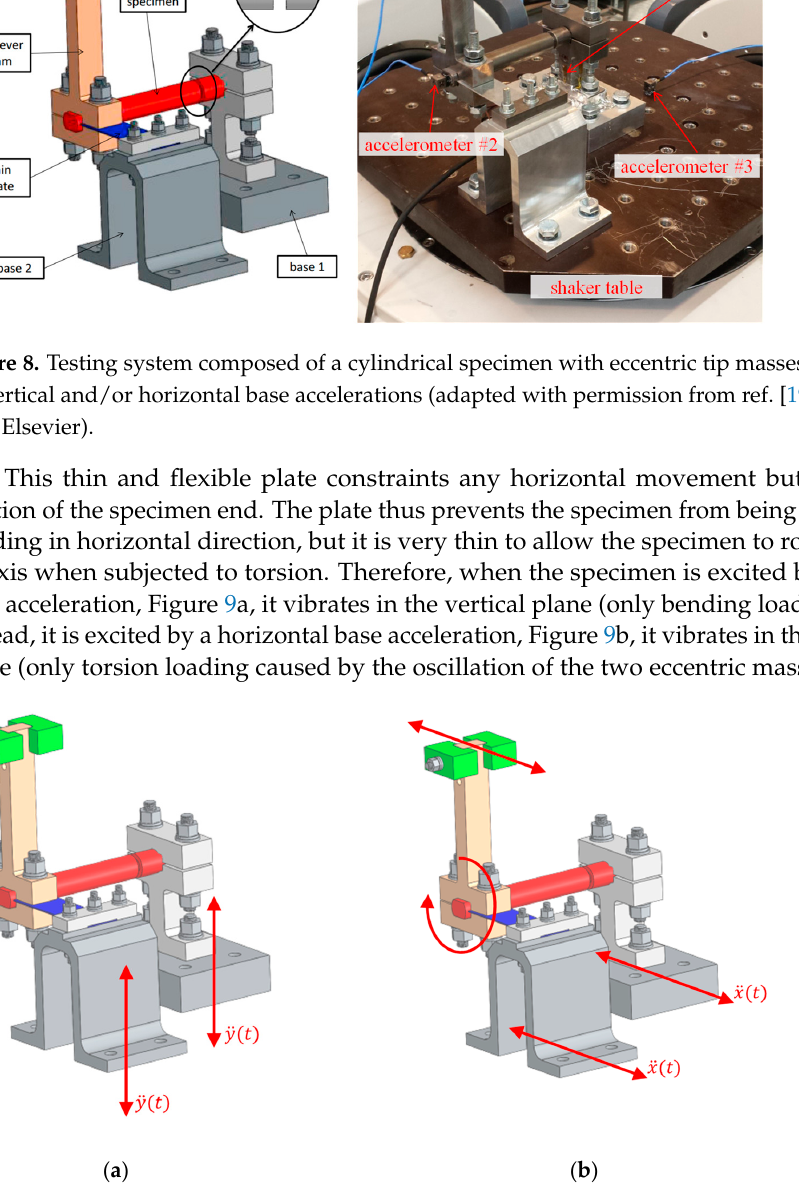
Figure 9. Testing system with a cylindrical specimen excited by ( a ) vertical base acceleration and ( b ) horizontal base ac- celeration. horizontal base